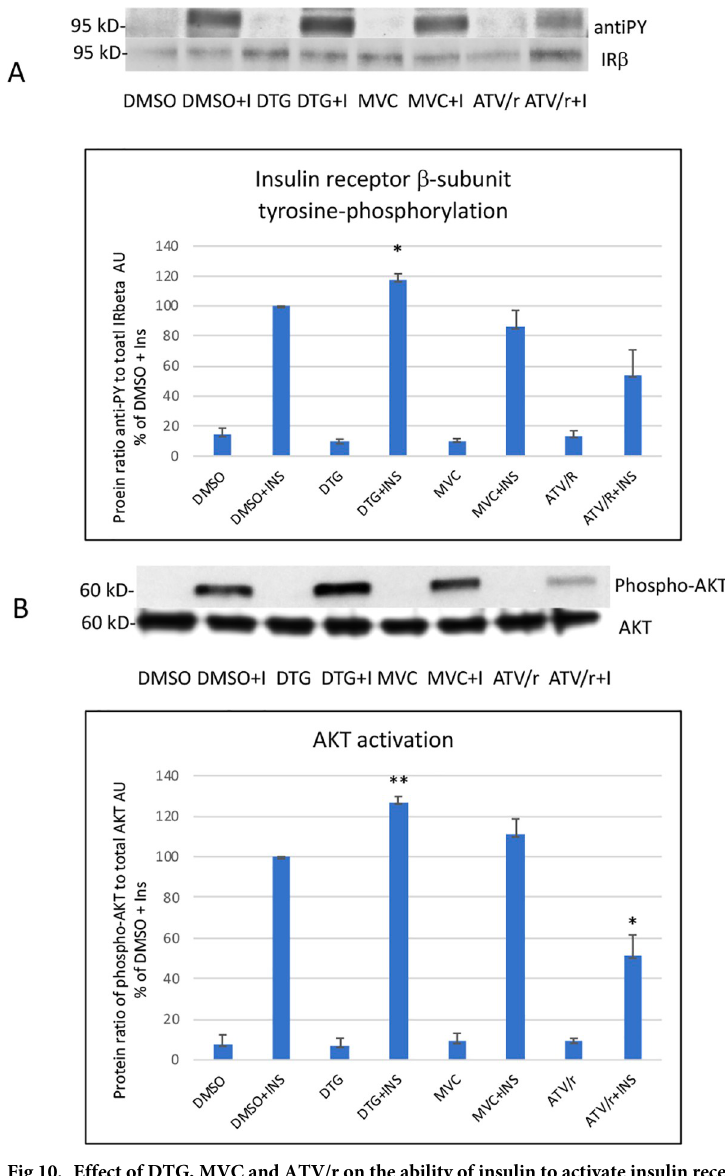
Fig 10. Effect of DTG, MVC and ATV/r on the ability of insulin to activate insulin receptor β -subunit tyrosine phosphorylation (A) and AKT (B). A representative Western blot of the level of tyrosine phosphorylation and of the total level of insulin receptor β -subunit is shown in A and of phospho-AKT and total AKT in B. Insulin receptor activation was analyzed by the ratio of tyrosine phosphorylation to the total level of the insulin receptor β -subunit and AKT activation by the ratio of phospho-AKT to total AKT The histograms represent the mean+/-SEM value as compared to the DMSO control set at 100% of 3 independent experiments. Anti-PY: anti-phospho-tyrosine, IR β : insulin receptor beta-subunit, I or INS: insulin The comparisons used Welch’s correction of Student T-test. � p < 0.05, �� p < 0.01 versus control